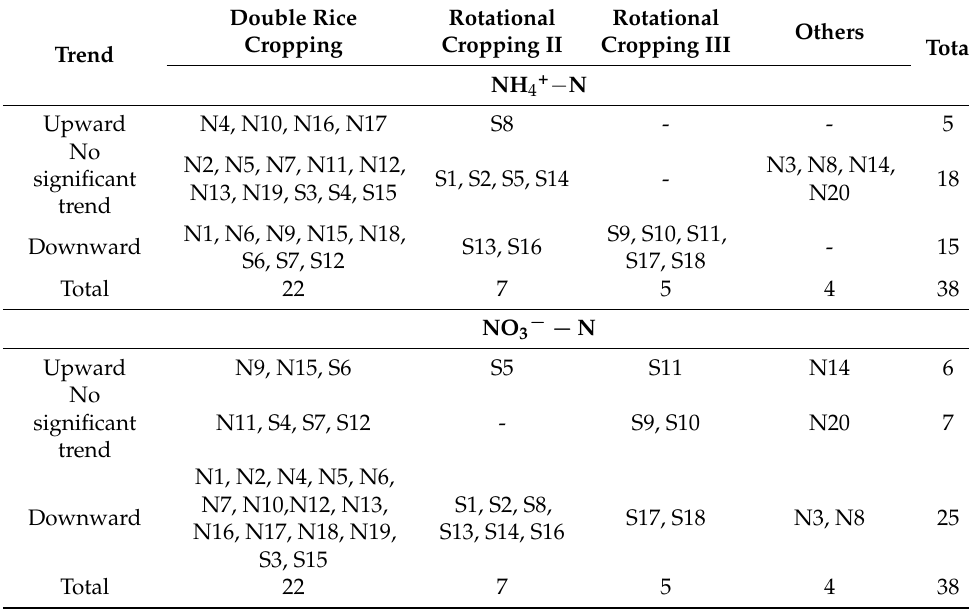
Table 2. The entire-period Mann–Kendall (MK) trends of ammonium–N and nitrate–N concentrations for each monitoring well in the study